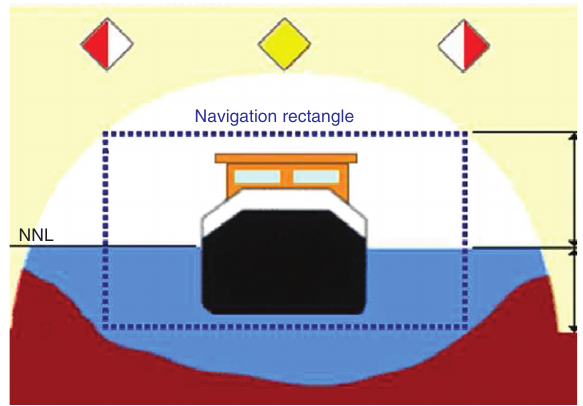
Figure 1. Normal Navigation Level Inside the Navigation